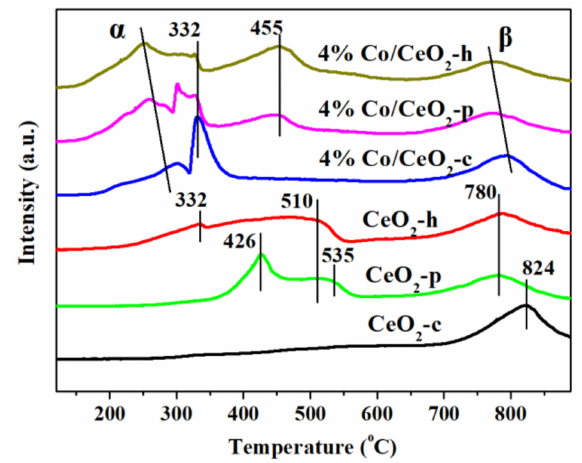
Figure 9. H 2 -TPR profiles of di ff erent CeO 2 supports and 4%Co / CeO 2